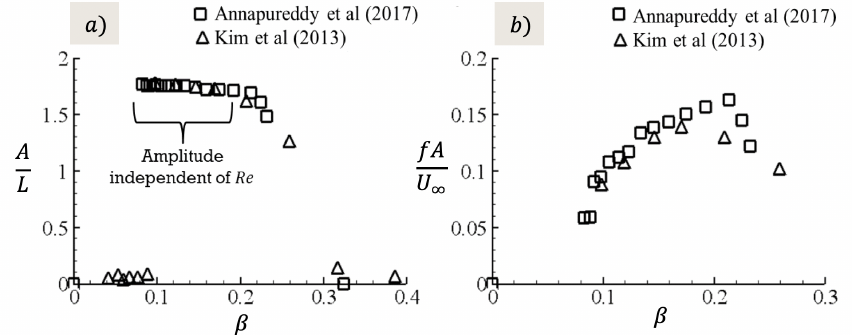
Figure 6. Variation of ( a ) non-dimensional flapping amplitude (A) ( b ) non-dimensional flapping frequency (f) with stiffness of the